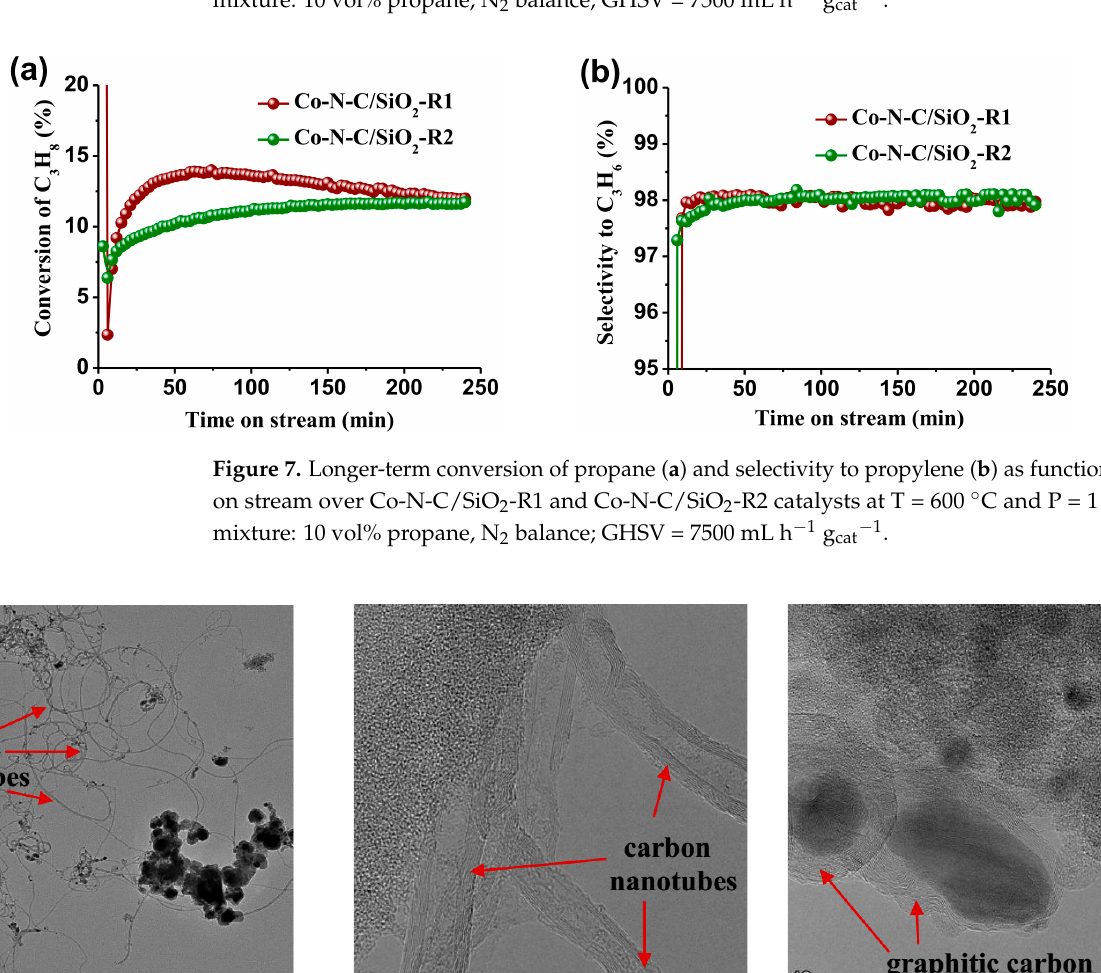
Figure 8. TEM images of the spent Co-N-C/SiO 2 catalyst (after 1 h of operation at T = 600 °C and P = 1 atm for the gas mixture of 10 vol% propane, N 2 balance, GHSV = 7500 mL h − 1 g cat − 1 ) showing ( a , b ) the growth of carbon nanotubes; ( c ) significant and dense packing graphitization of cobalt nano- particles.